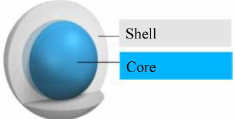
Figure 1. Structure of a microencapsulated phase change materials (PCM) (adapted from [5]).